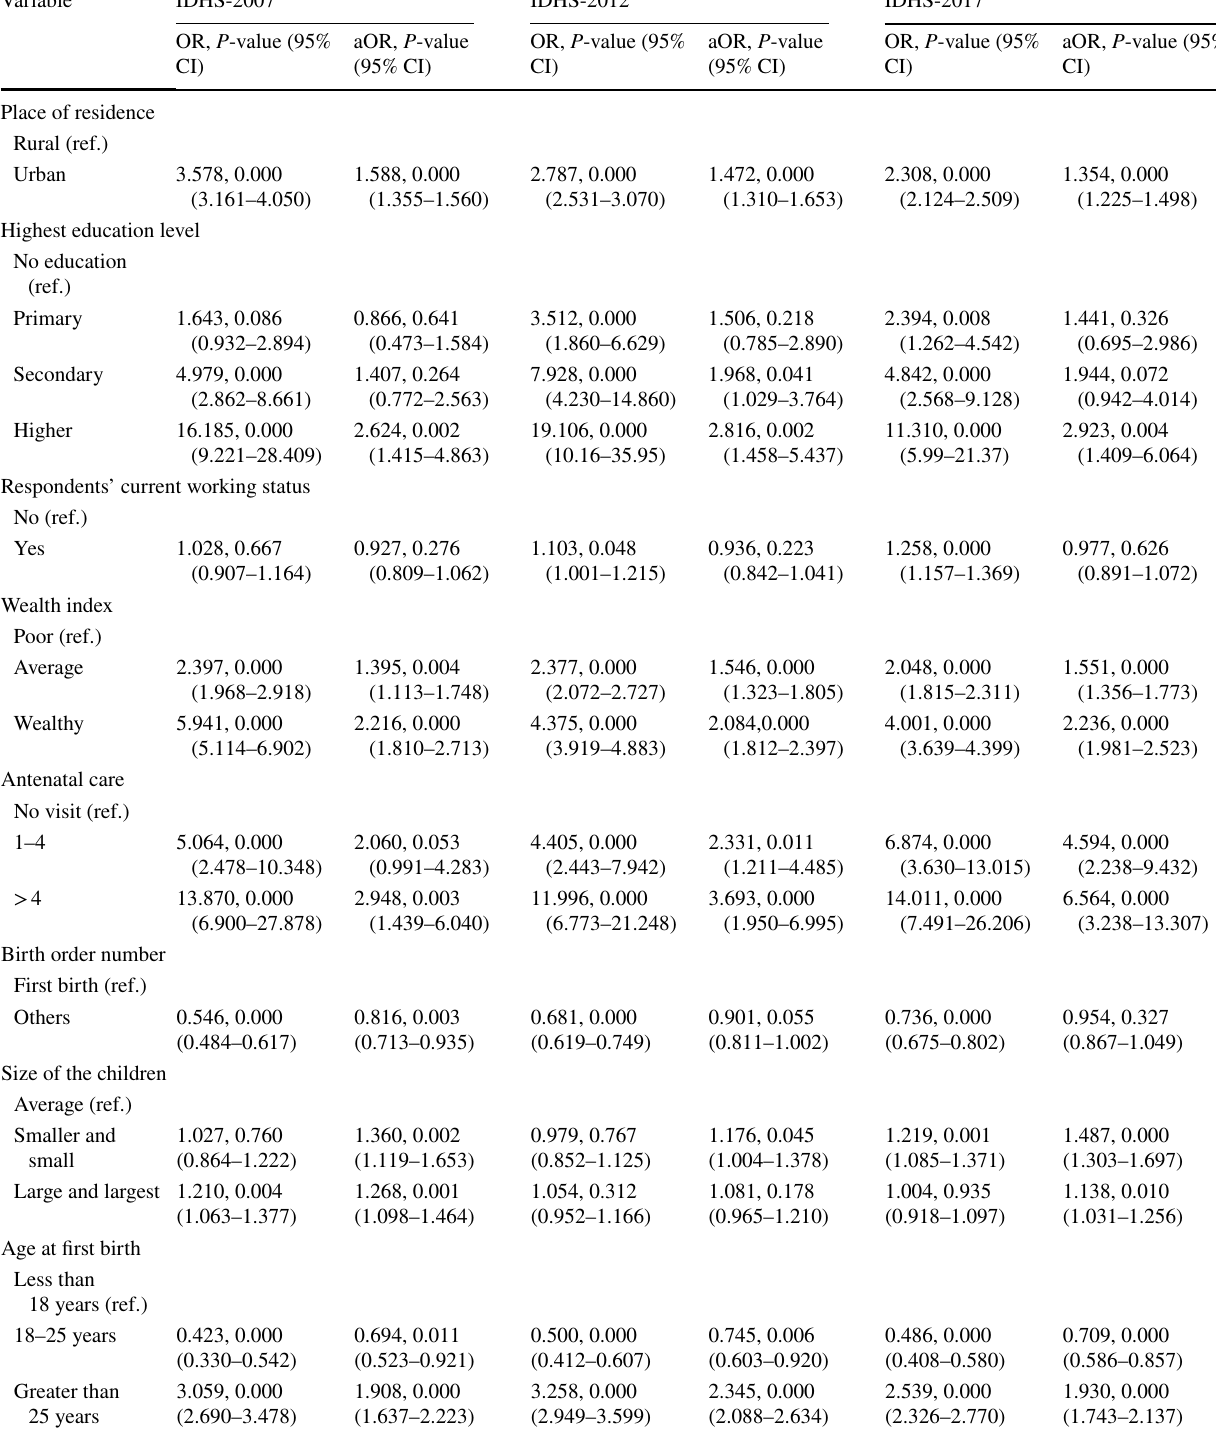
Table 2 Illustration of various socio-economic and demographic factors influencing the use of C-sections in Indonesia, 2007–2017, on the basis of binary logistic